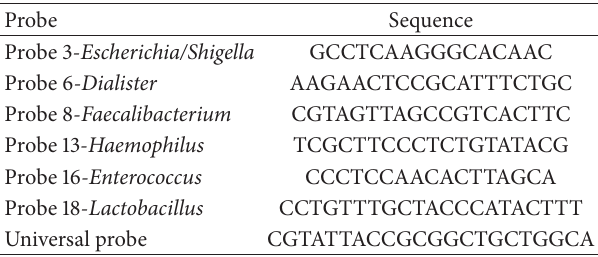
Table 2: Sequence of the probes used in the